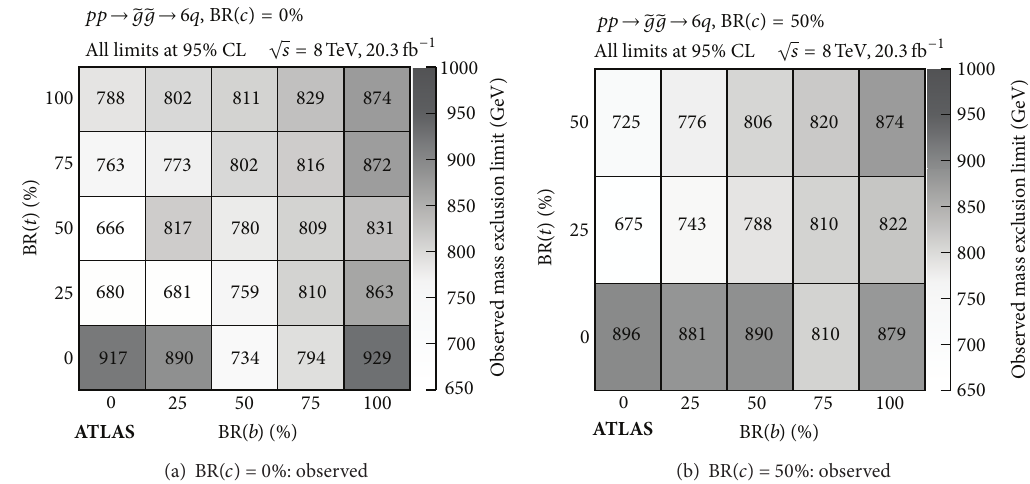
Figure 13: Observed mass exclusions at the 95% CL in the BR( 𝑡 ) versus BR( 𝑏 ) space for BR( 𝑐 ) = 0% (a) and BR( 𝑐 ) = 50% (b). Each point in this space is individually optimized and fit. Masses below these values are excluded in the six-quark model. Bin centers correspond to evaluated models (from [44]).